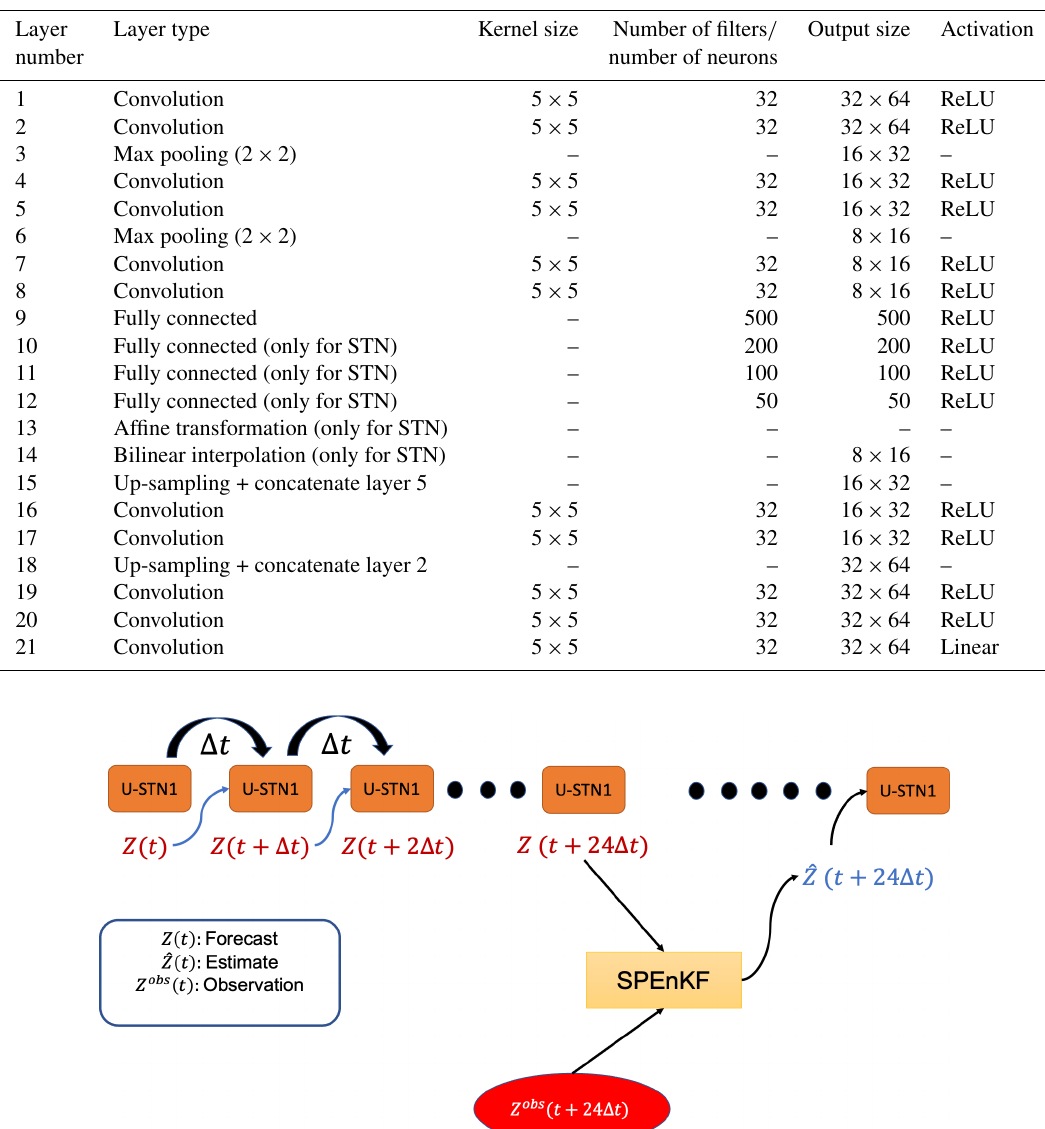
Table 2. Table presenting information on the U-STNx and U-NETx architecture with the optimal set of hyperparameters that have been obtained after extensive trial and error. Note that apart from the affine transformation and bilinear interpolation layer, the U-STNx and U-NETx architectures are similar. The networks have been implemented in Tensorflow and Keras.